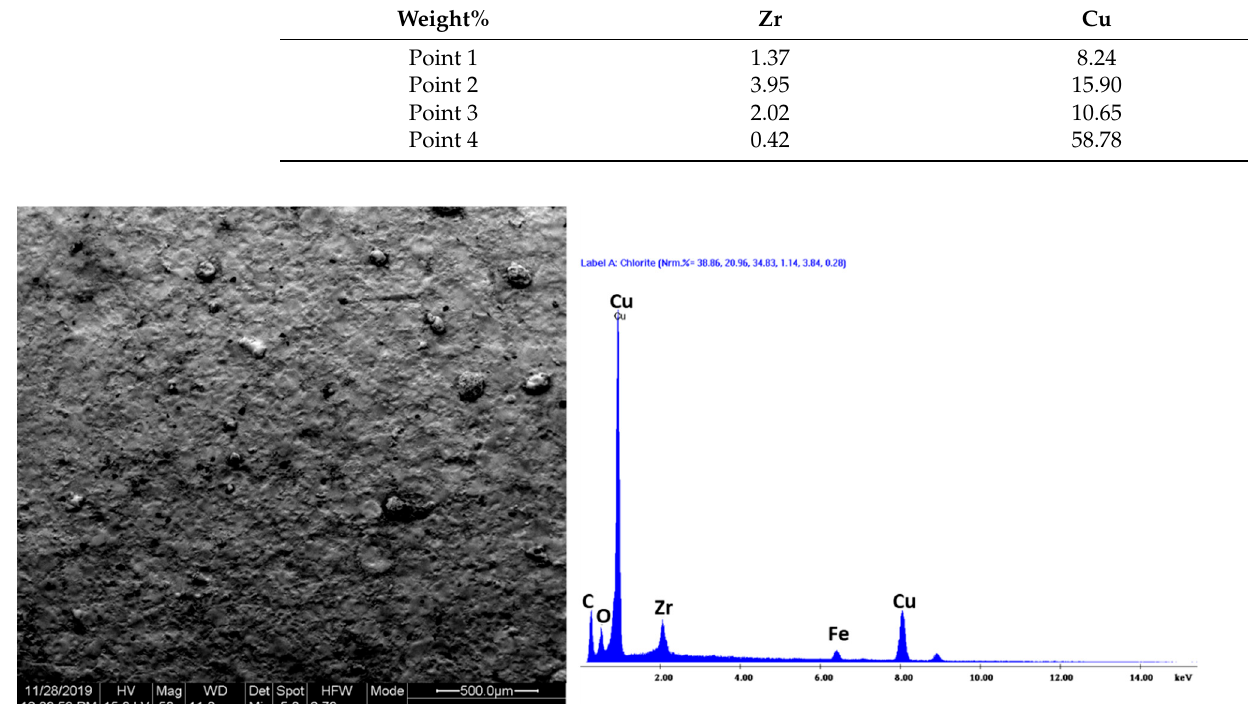
Figure 4. SEM micrograph and EDS spectrum of machined surface for Ip = 5 A and Ton = 25 μ s.